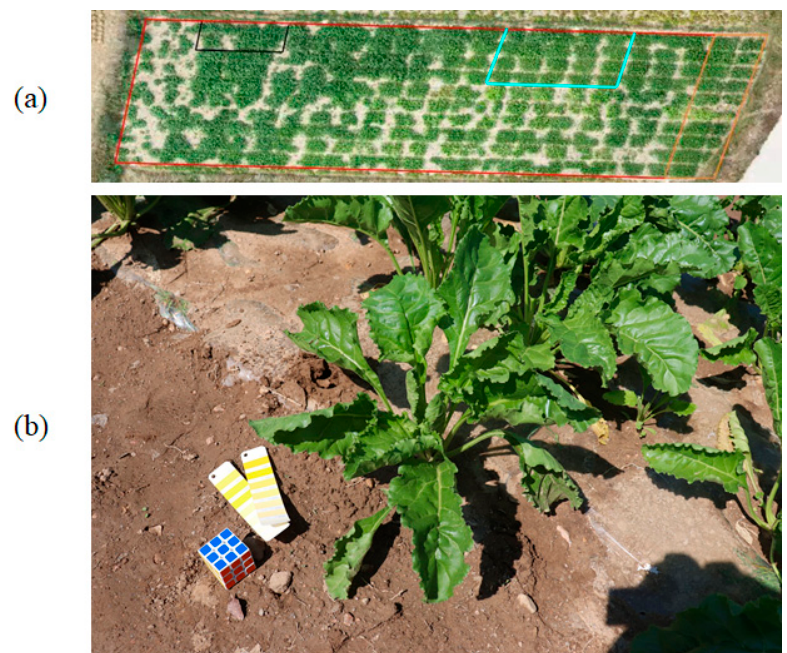
Figure 1. ( a ) A site map taken with a drone in July 2019. The 20 plots in the blue box are planted with the sugar beet plants studied in this article. ( b ) A photo of the plants in the field with a Rubik’s